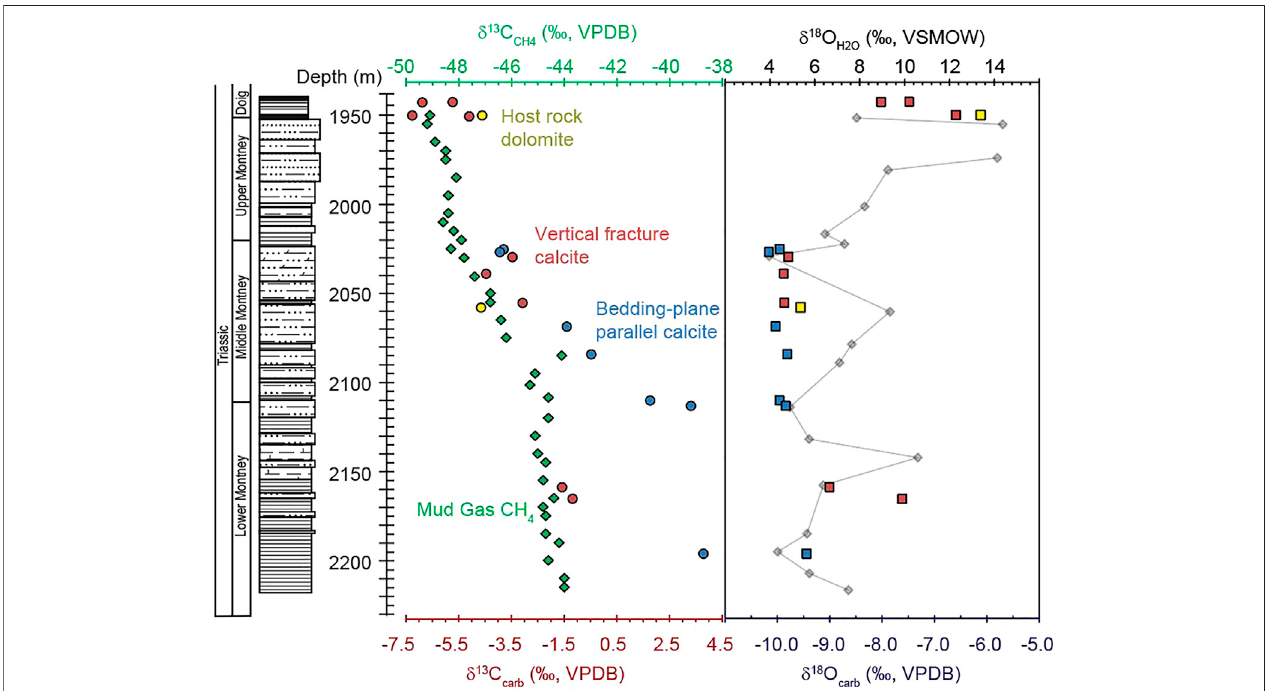
FIGURE 9 | Downhole variability in δ 13 C values of vertical fracture calcite (red circles), horizontal bedding-plane parallel fracture calcite (blue circles), host rock dolomite(yellow circles),andmethanederivedfrommud-gasduring drilling(green diamonds).Allcarbonatevalues(verticaland horizontal bedding-plane parallel calcite) areplottedalongbottomscale,andmud-gasCH 4 isplottedalongtopscale.Notethemagnitudeof δ 13 Cscalesformethaneandcarbonatesareequivalent,butdifferent values. δ 18 Ovaluesoffracturecalcite(redandgreenboxes)plottedalongside δ 18 Oofporewater(greydiamonds).StratigraphyadaptedfromLaycocketal.(2021).